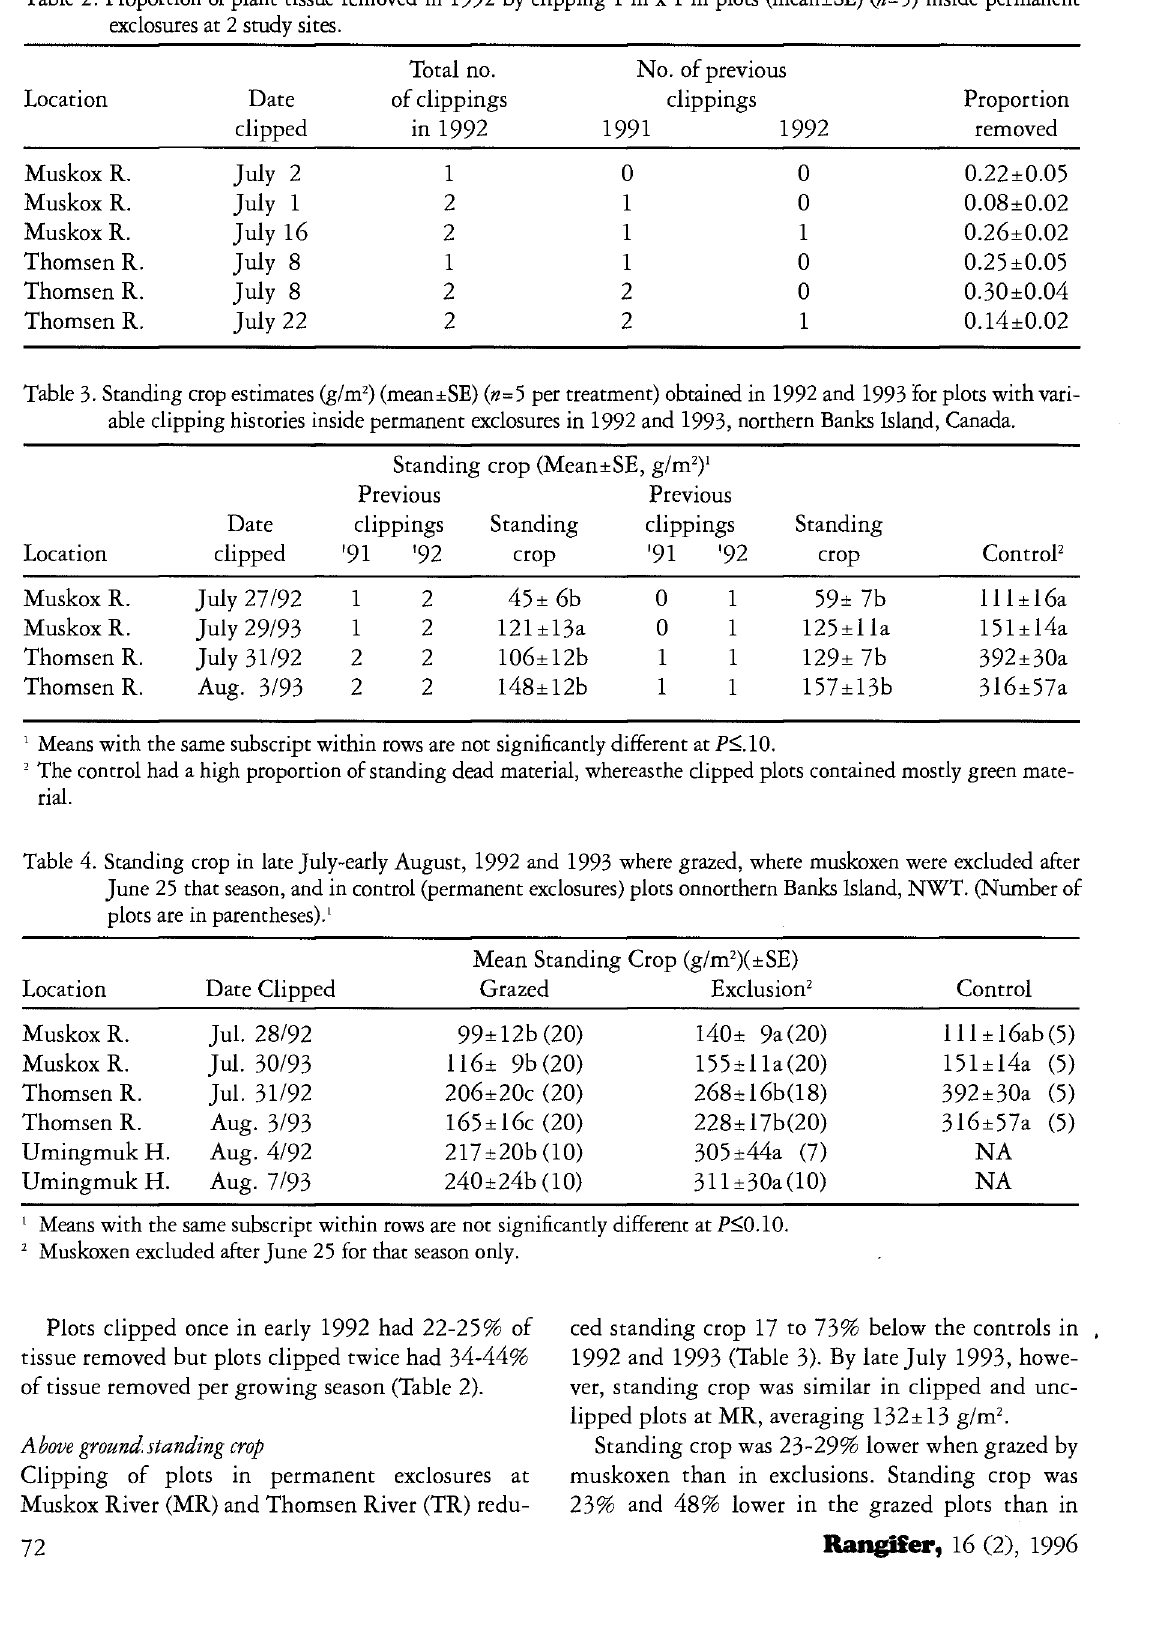
Table 2. Proportion of plant tissue removed in 1992 by clipping 1 m x 1 m plots (mean±SE) (n=5) inside permanent exclosures at 2 study sites.